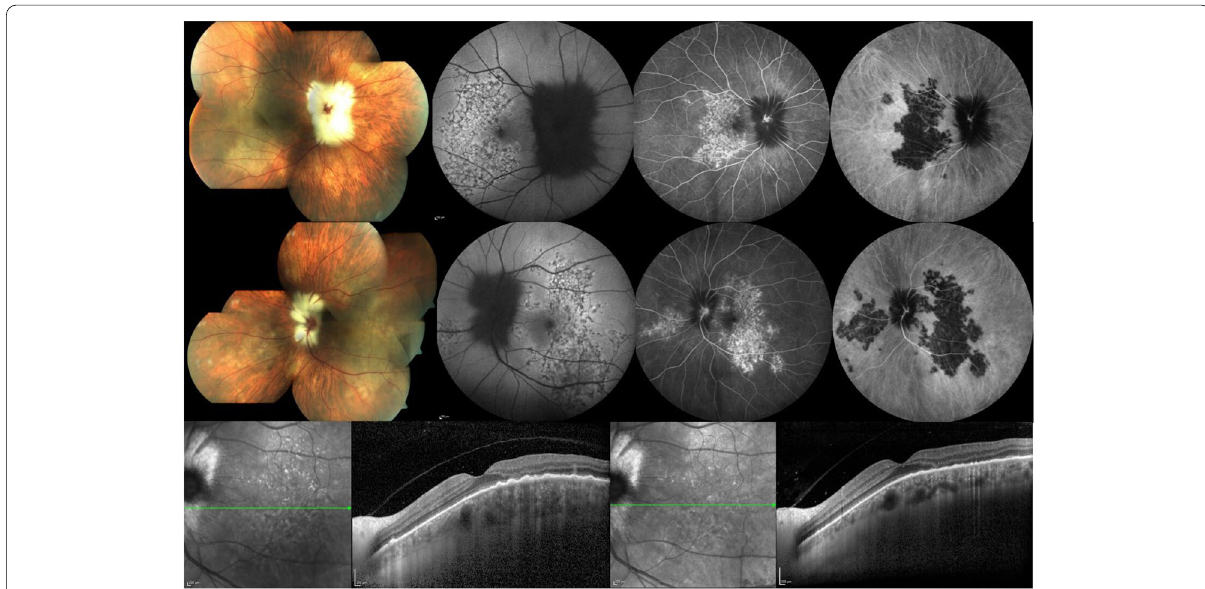
Fig. 6 Color fundus photography, dual fluorescein‑indocyanine green angiography and optical coherence tomography imaging of a 63 year‑old woman who presented with photopsias and loss of vision after tapering oral corticosteroid given in combination with azathioprine for the treatment of granulomatosis with polyangiitis diagnosed 2 months prior. Montage color fundus photographs of the right ( top row, first frame ) and the left ( middle row first frame ) eye show myelinated nerve fibers obscuring the optic disc margins, deep creamy‑white serpiginoid choroiditis involving the posterior pole in both eyes and inferonasal to the disc in the left eye. Fundus autofluorescence imaging shows a granular pattern of hyper‑ and hypoautofluorescence of the lesions in the right ( top row, second frame ) and the left eye ( middle row, second frame ). Dual fluorescein‑indocyanine green angiography frames at 8 min show window defects and staining on fluorescein angiography and diffuse hypofluorescence of the lesions on indocyanine green angiography in the right ( top row, third and fourth frames, respectively ) and the left eye ( middle row, third and fourth frames, respectively ). EDI‑OCT of the left eye shows loss of outer retinal layers, RPE irregularities, thickening of the choroid, and hyperreflective dots in the choroid in the involved area ( bottom row, left ). After intravenous pulse methylprednisolone 1 g for 3 days, EDI‑OCT shows partial improvement of RPE irregularity and reduced thickening of the choroid ( bottom row, right ). Visual acuity increased from counting fingers in both eyes to 20/40 in the right and 20/32 in the left eye. Active and latent tuberculosis had already been ruled out and